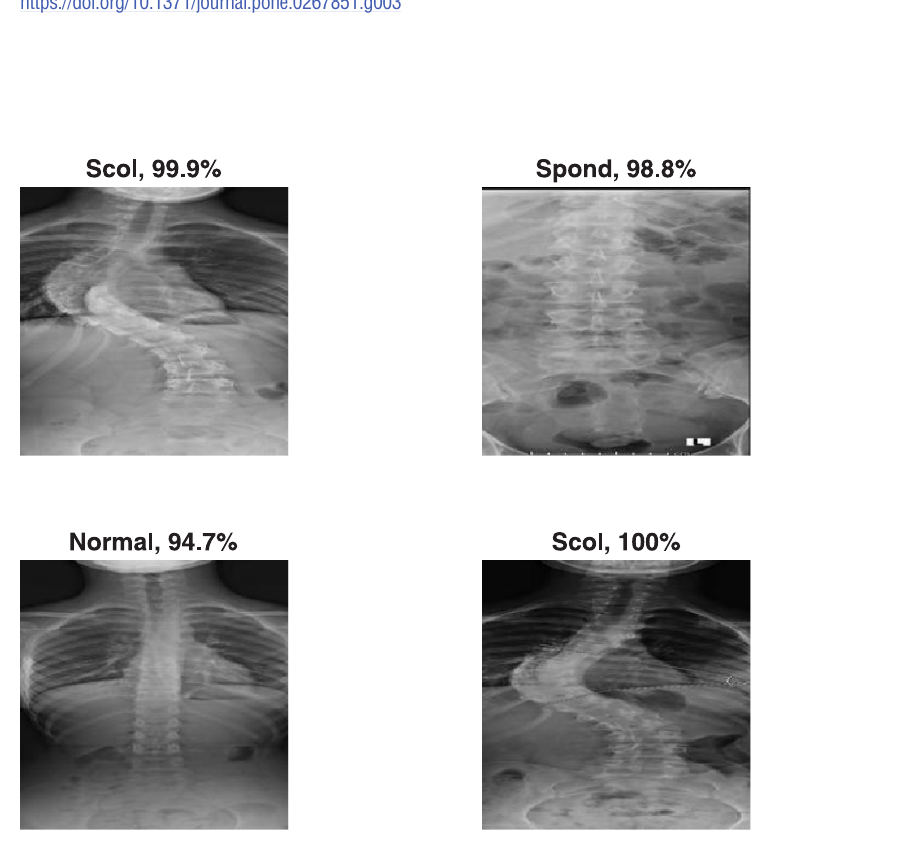
Fig 4. A sample output from the three class classification